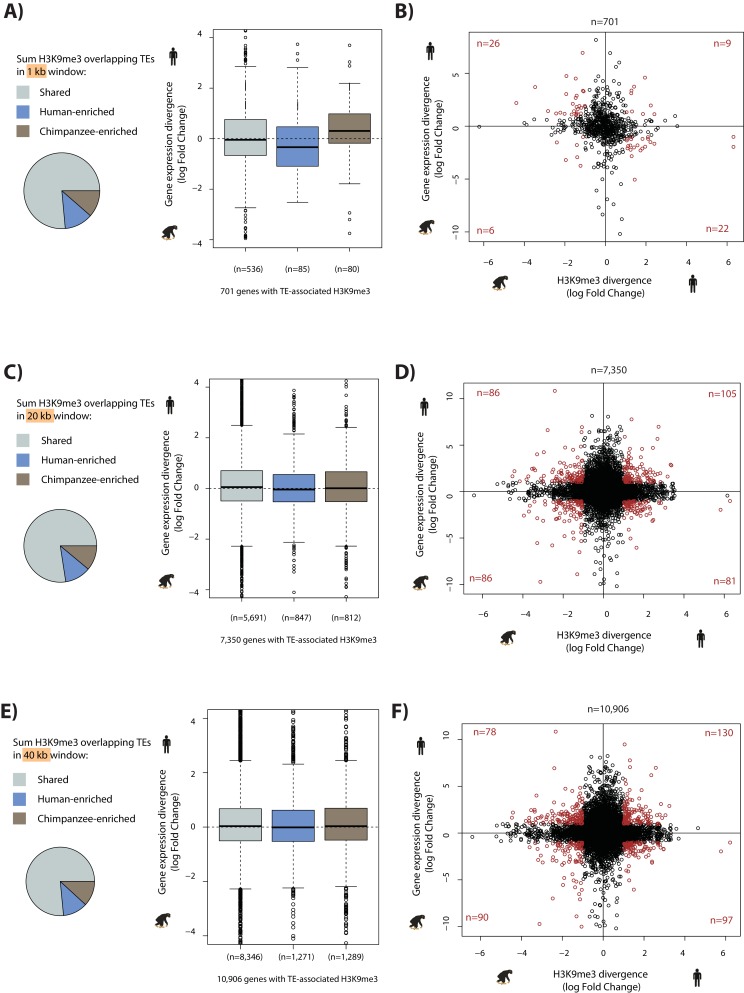
TEs preferentially enriched for H3K9me3 in one species only have a minimal effect on gene expression divergence at the TSS.(A) Gene expression divergence between human and chimpanzee for genes with TEs overlapping H3K9me3 within 1 kb upstream of the TSS. Genes are categorized by H3K9me3 enrichment at FDR < 0.01. (B) Interspecies divergence in H3K9me3-mediated silencing of TEs in a 1 kb window upstream of the TSS versus gene expression divergence. Genes which have a H3K9me3 log fold divergence of >1 or <-1, and a gene expression divergence log fold change of >1 or <-1 are shown in red. (C) As in (A) except using a 20 kb window. (D) As in (B) except using a 20 kb window. (E) As in (A) except using a 40 kb window. (F) As in (B) except using a 40 kb window. There are no significant differences between categories.